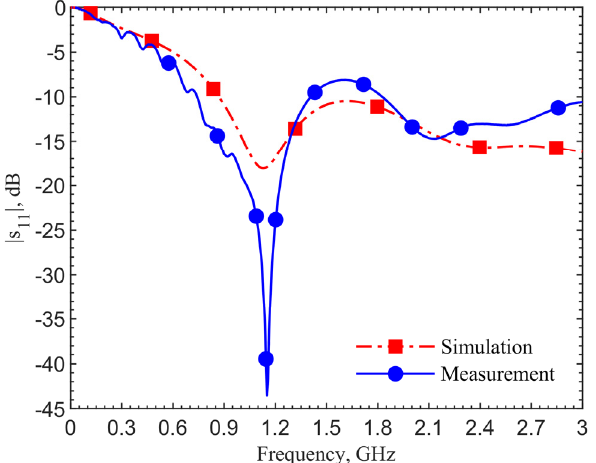
Figure 10. Simulations show frequency matching after a relative permittivity decrease of 25 and a conductivity decrease of 0.35 S/m.